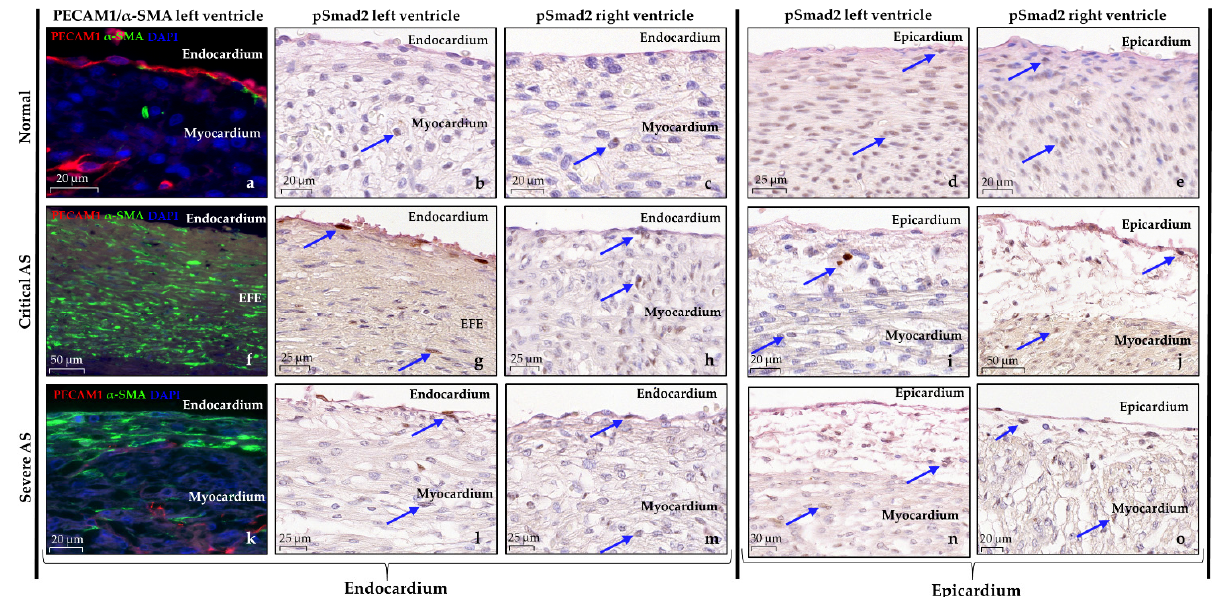
Figure 5. Altered expression markers of EndMT and EMT in cases with aortic stenosis. ( a ) In normal hearts, the endocardium consists of a flat layer of PECAM1 expressing endothelial cells (red) and a thin subendocardial connective tissue layer containing α -SMA positive cells (green). ( b – e ) Phospho-Smad2 (pSmad2) expression is rare at the endothelial site but highly present at the epicardial site; ( f – o ) Different expression profiles are seen in AS cases; ( f , k ) The EFE consists largely of α -SMA positive cells, representing activated fibroblasts. No PECAM1 positive endothelial cells are observed; ( g , h , l , m ) More expression of pSmad2 is found in the endothelial cells and cells in the EFE compared to normal hearts, which is similar between LV and RV; ( i , j , n , o ). At the epicardial site, the epicardium is thickened, rarely showing expression of pSmad2 in the LV of the critical AS cases while the LV of the severe AS specimen reveals a milder reduction in expression; ( j , o ) both RVs more closely resemble the normal hearts. PECAM1, platelet endothelial cell adhesion molecule-1; α -SMA, alpha smooth muscle actin; pSmad2, phosphorylated Smad2.